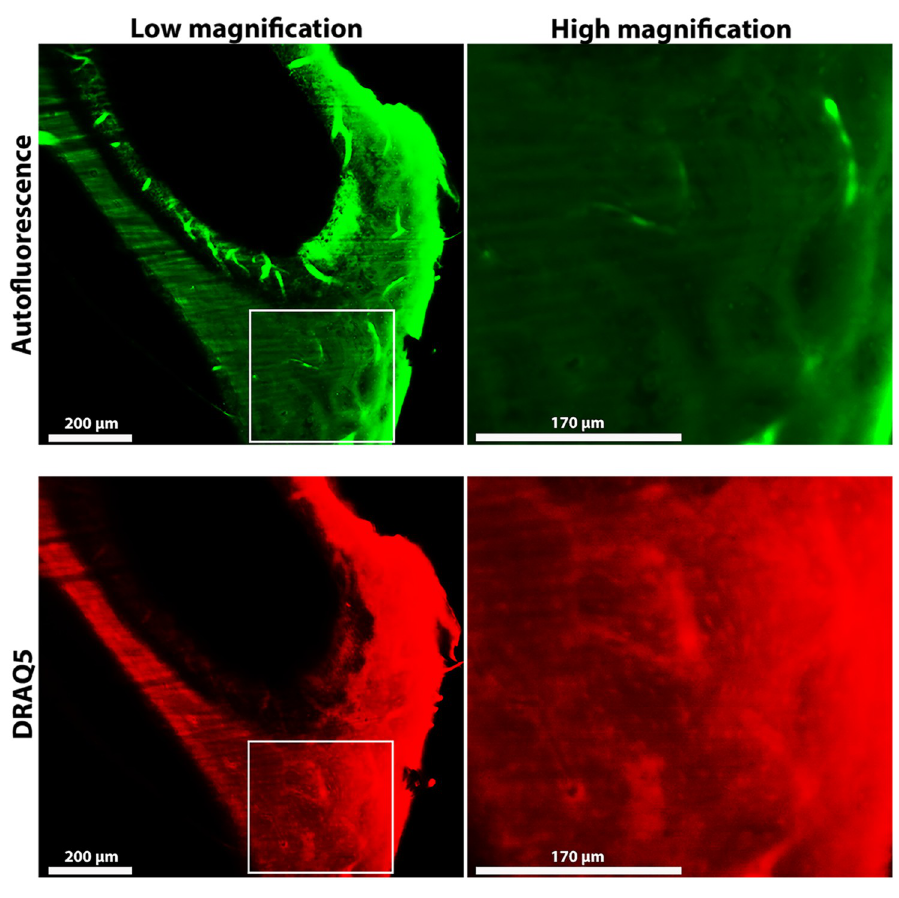
Fig 6. Light-sheet fluorescent microscopy images of a cleared pig petrous bone. All images are from the same Z- depth with (green) autofluorescence and (red) DRAQ5 signals. Low magnification images show the cleared bone tissue from the cochlear cavities towards the outer bone surface. High magnification images of areas indicated by the rectangles are shown. The local concentrations of DRAQ5 stained nuclei can best be seen in the high magnification